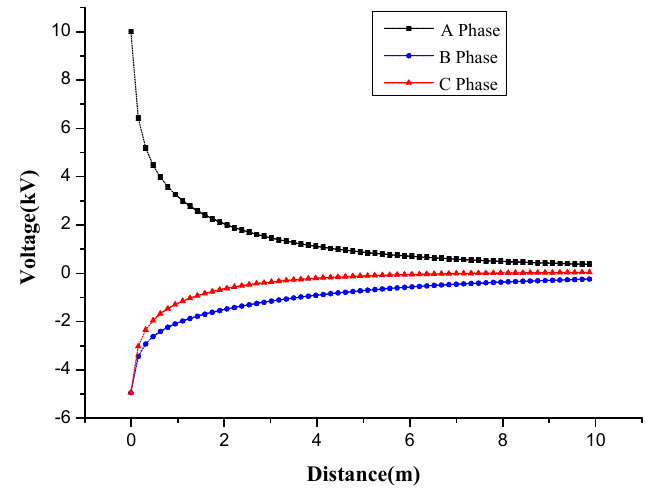
Figure 4. Voltage value under three phase transmission lines.